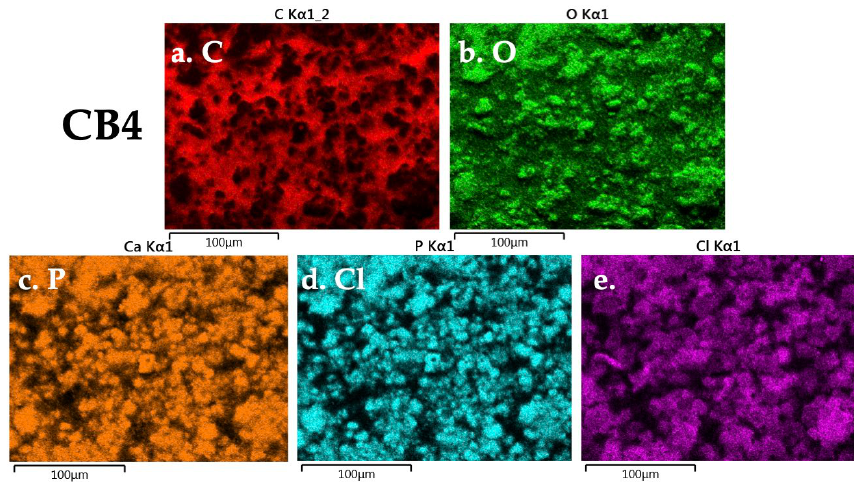
Figure A4. EDX identified elements for CB4: ( a ) C, ( b ) O, ( c ) Ca, ( d ) P, ( e ) Cl. Table A1. The wavenumber values for each functional groups of the polymers, HA and the four CBs, identified by ATR-FTIR.